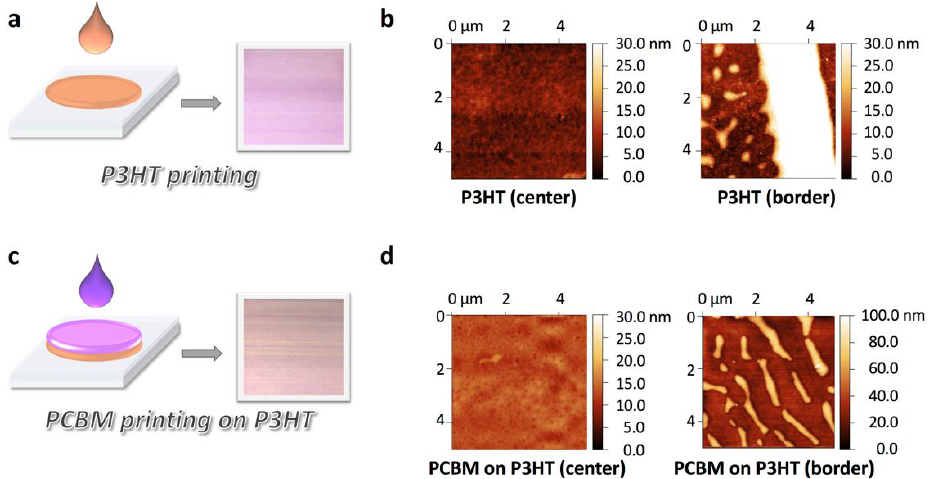
Figure 3. Optical and AFM characterization of the sequentially inkjet-printed P3HT:PCBM pat- terns: ( a ) P3HT droplet deposition and optical characterization of the resulting printed P3HT layer (20 × 20 mm 2 ); ( b ) AFM characterization of the printed film within the center of the P3HT droplet (image at the left) and the border of a single droplet (image at the right); ( c ) PCBM droplet deposition on the top of the previously printed P3HT layer, leading to a P3HT:PCBM layer; ( d ) AFM characterization of the printed film at the center (image at the left) and at the border (image at the right) of the printed PCBM droplet.